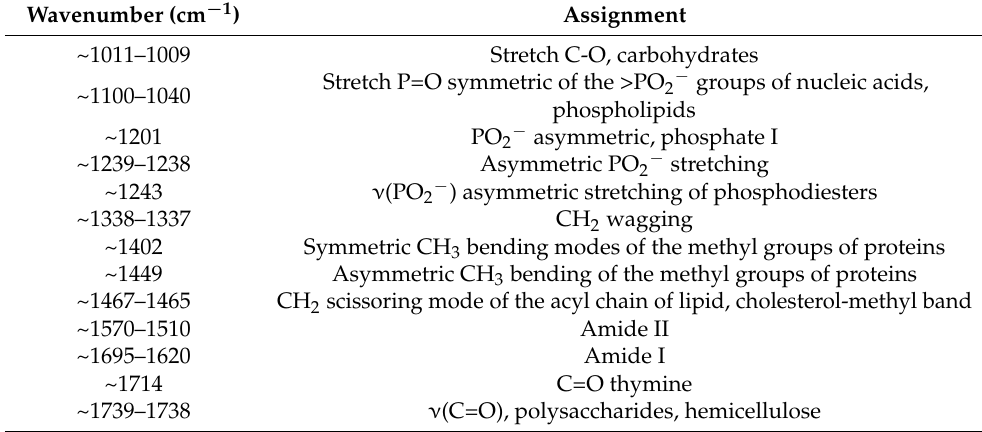
Table 1. Peak component